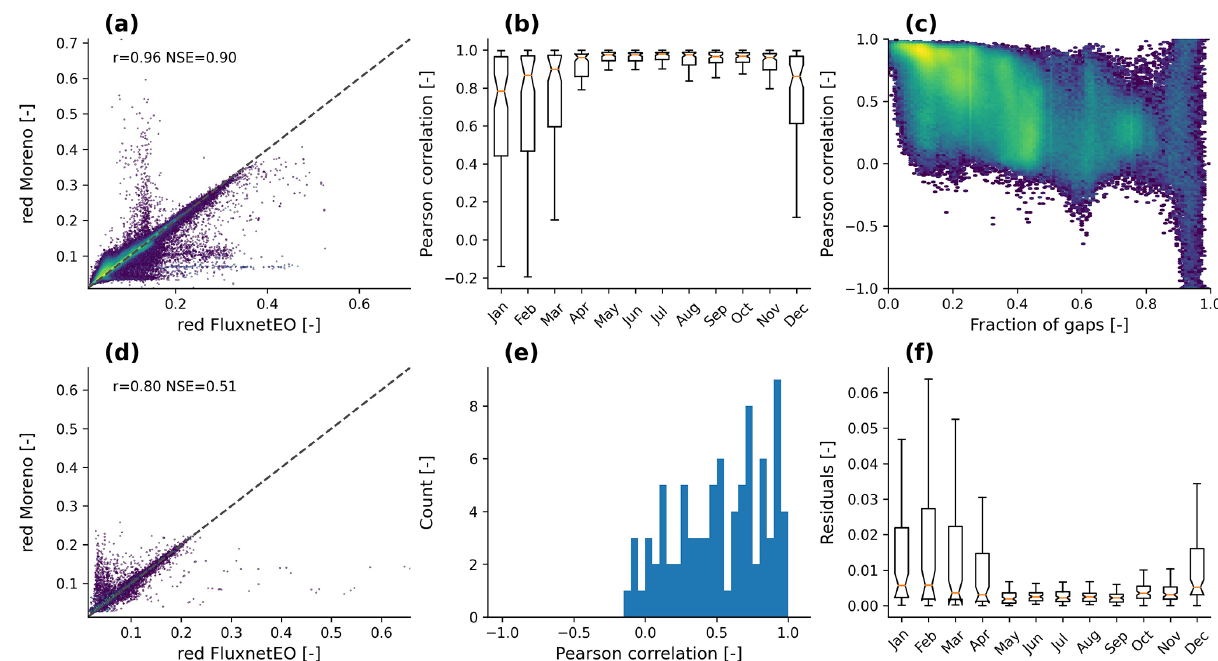
Figure C5. Same as Fig. C3 but for the red spectral